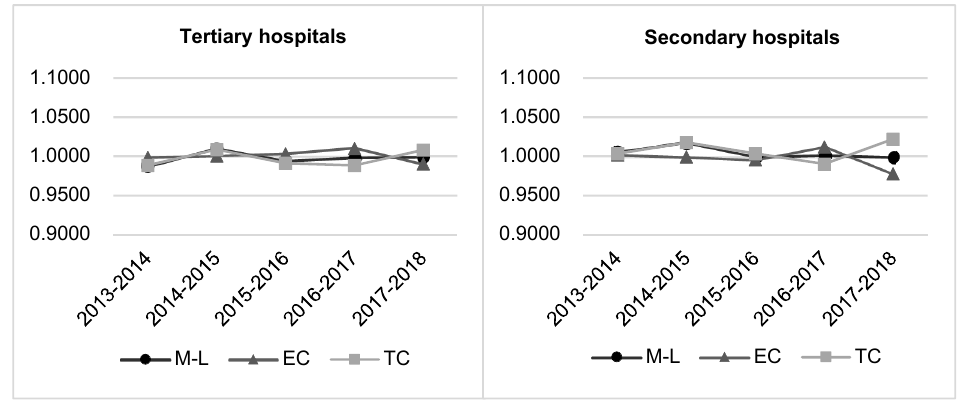
Figure 2. The annual growths of TFP (total factor productivity), EC (efficiency change) and TC (technical change) in tertiary and secondary hospitals.